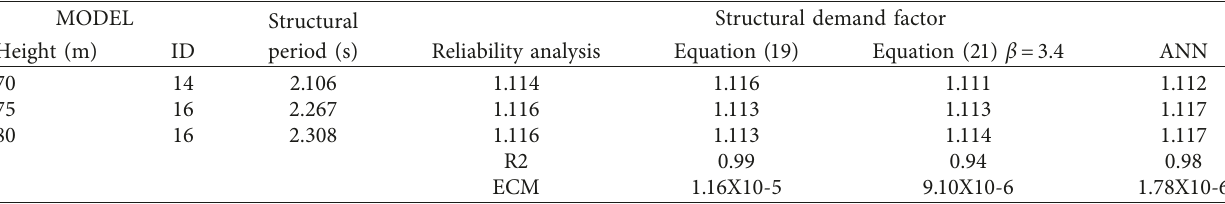
Table 9: Comparison of structural demand factor results.